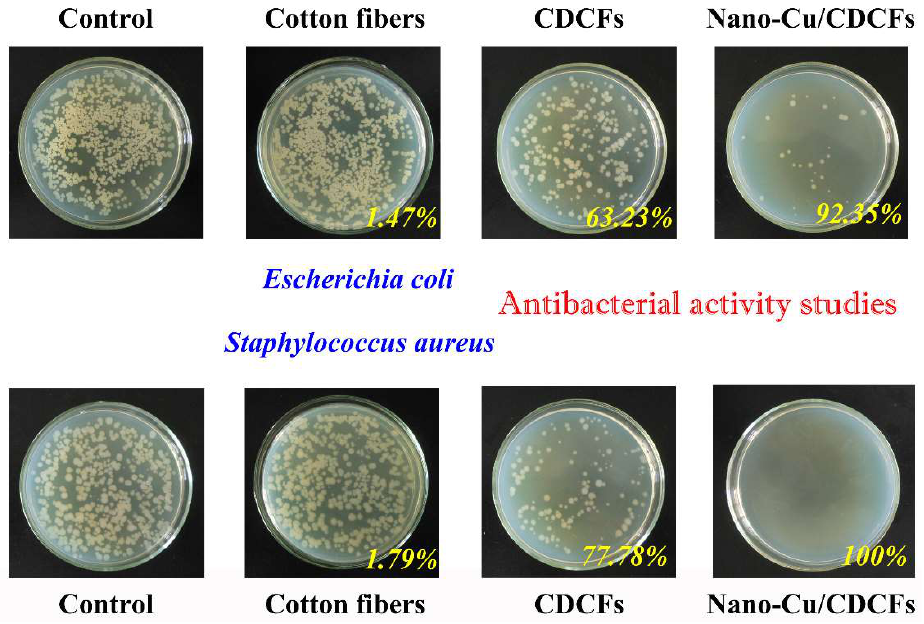
Figure 5. Antibacterial activity studies of the cotton fibers, CDCFs and nano-Cu/CDCFs using a shake flask method.